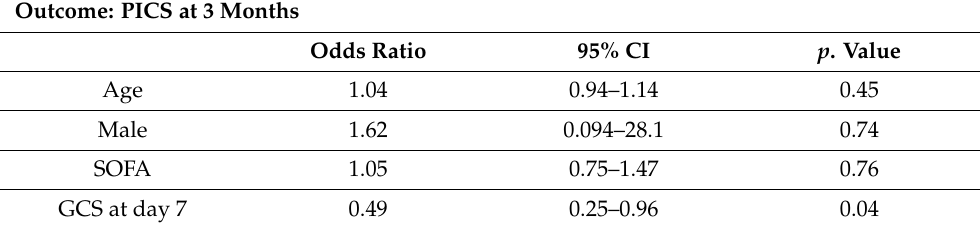
Table 5. Prediction of PICS at 3